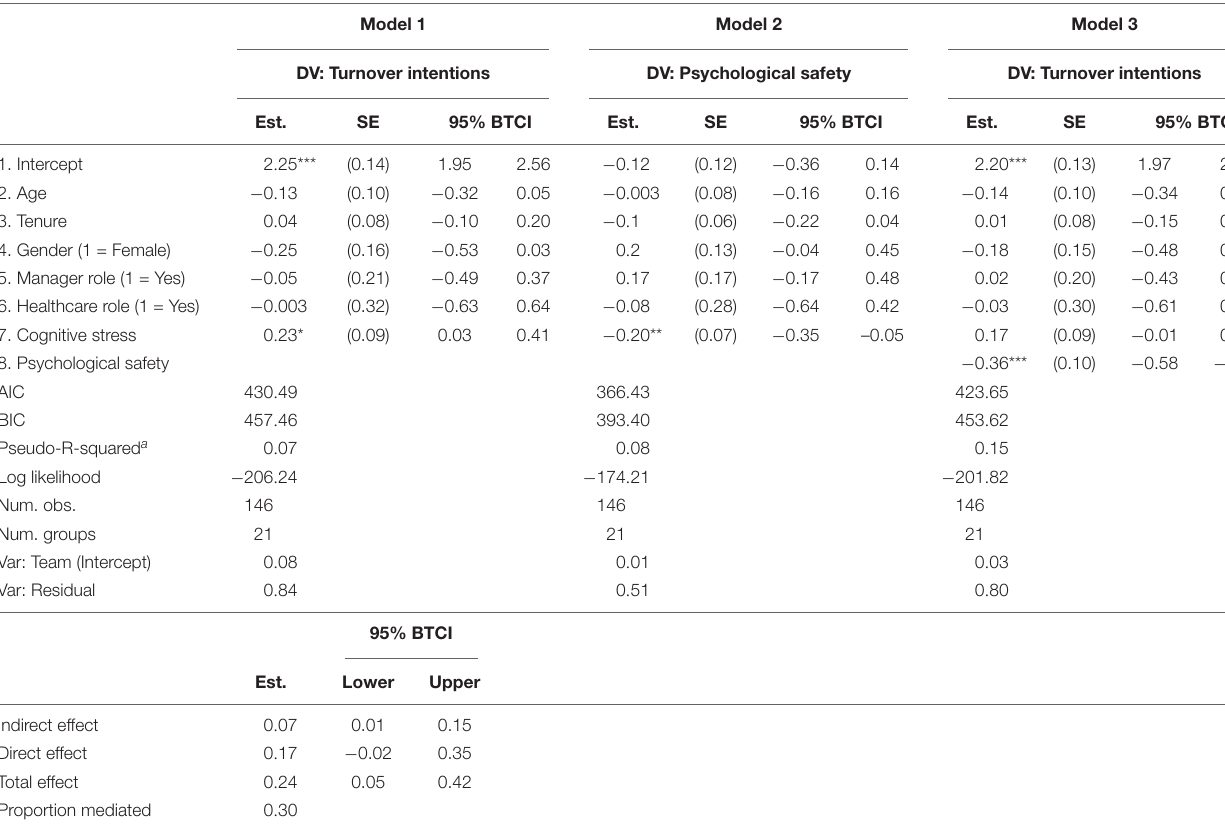
Figure 2 . Higher levels of stress combined with a deep worry for COVID-19 will have a more negative effect on the team members psychological